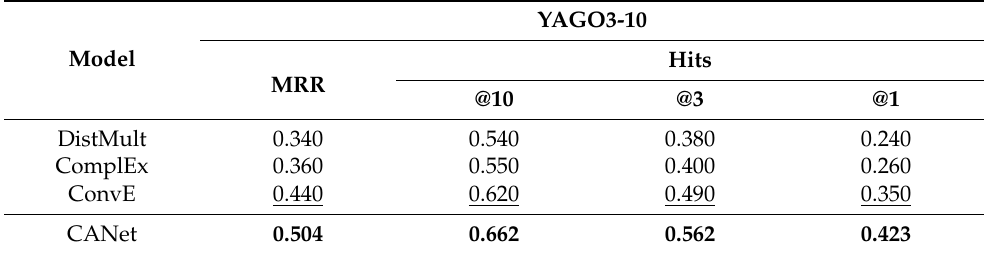
Table 4. The MRR and Hits@k of the link prediction results on the YAGO3-10 dataset.